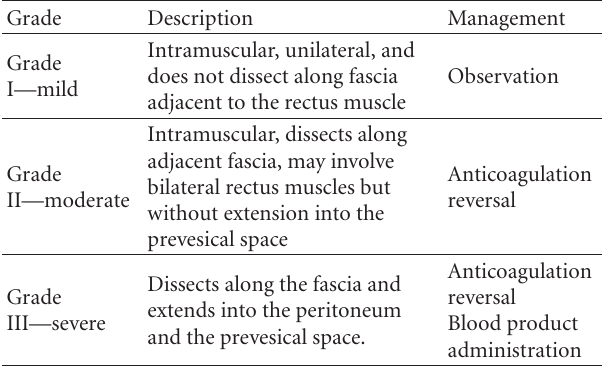
Table 2: Diagnostic classification of rectus sheath hematoma